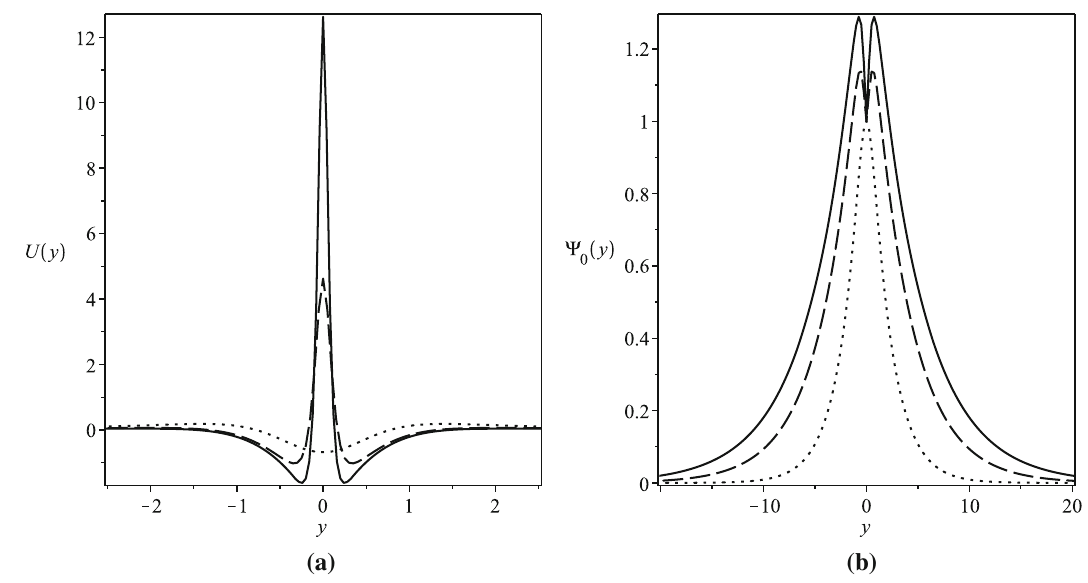
α = − 5 (solid line), α = − 2 (dashed 2 with α 1 T 1 1 2